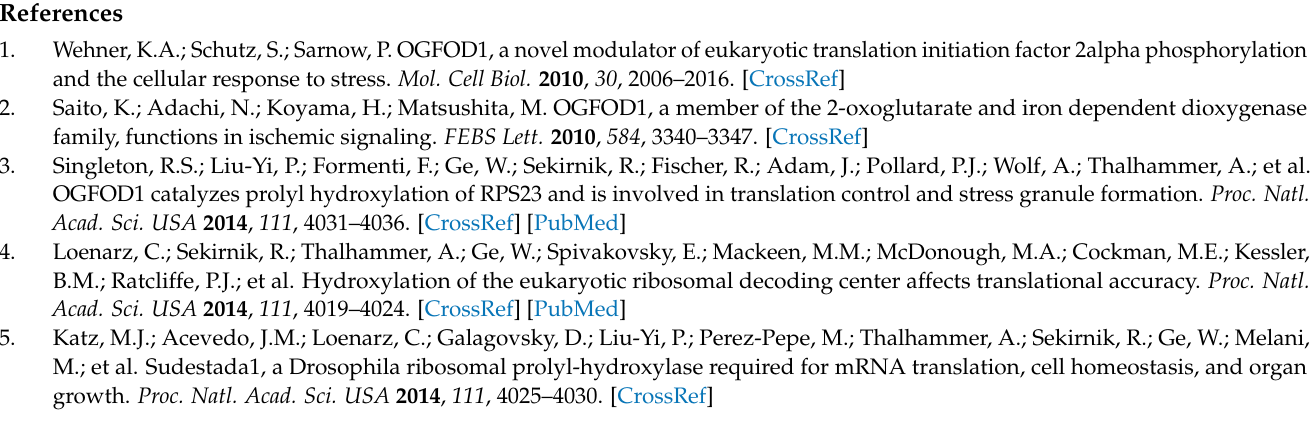
Figure S2: Altered genes by OGFOD1 KO in MDA-MB-231, Figure S3: P-TEFb phosphorylates serine 256 residue of OGFOD1 in vitro, Figure S4: The generation of customized anti-phosphorylated serine 256 OGFOD1 antibody, Supplementary Figure S5: Altered gene expression levels in Mock, OGFOD1 KO, KO+WT, KO+S256A, Figures S6–S15: Source data, Table S1: Primer list for knockout, RT-qPCR, and ChIP-qPCR, Table S2: RNA sequencing data values for mock versus OGFOD1